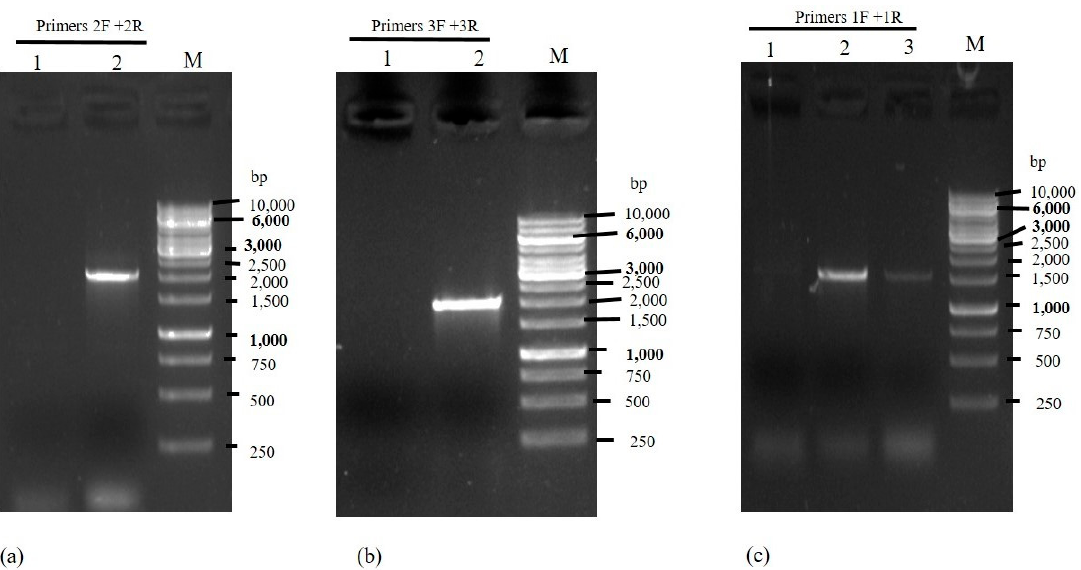
Figure 2. PCR amplification in Mc-cmal-2075, Mc-cmalA-4, and Mc-cmalB-5 strains. ( a ) PCR amplification of cmalA gene and 3 ′ carRP region using primer pair 2F/2R in overexpressing transformant Mc-cmalA-4 strain. Lane M: Marker. Lane 1 represents the control, Lane 2 shows the result of the PCR amplification that confirmed the presence of cmalA gene in the overexpressing transformant. ( b ) PCR amplification of cmalB gene and 3 (cid:48) carRP region using primer pair 3F/3R in overexpressing transformant Mc-cmalB-5 strain. Lane M: Marker, Lane 1 represents the control, Lane 2 shows the result of the PCR amplification that confirmed the presence of cmalB gene in the overexpressing transformant. ( c ) PCR amplification of pyrF genes and 5 (cid:48) carRP regions in Mc-cmal-2075, Mc-cmalA-4, and Mc-cmalB-5 strains using primer pairs 1F/1R. Lane M: Marker. Lane 1 represents the control. Lanes 2 and 3 show presence of pyrF gene in Mc-cmalA-4 and Mc-cmalB-5 strains,